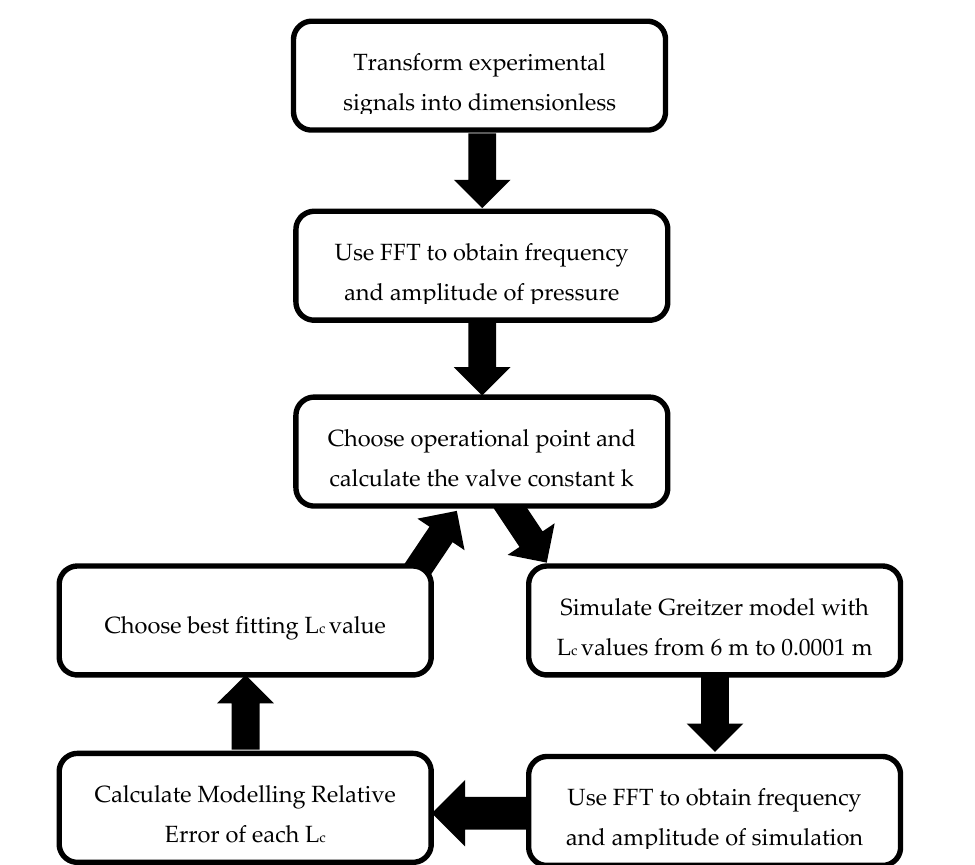
Figure 5. Modelling algorithm.